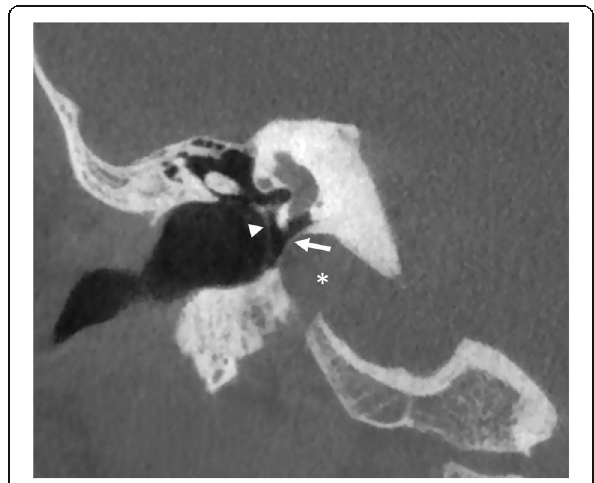
Fig. 8 Jugular bulb protrusion . Coronal CBCT scan shows prominence of the right jugular bulb (asterisk) into the hypotympanic cavity; the bony plate covering the vein is thinned (arrow). Tympanic membrane